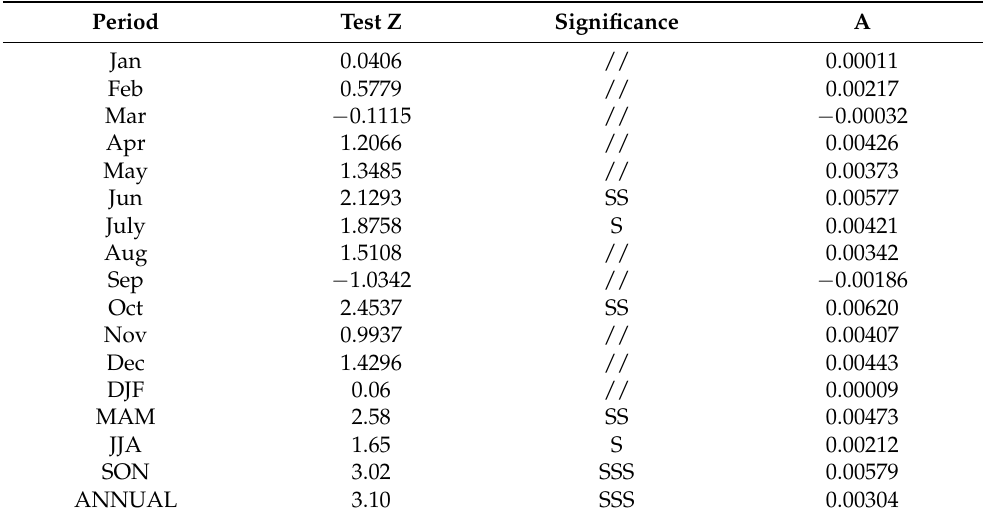
Table 6. Tm monthly, seasonal, and annual analyses. The MK trend is reported in the second and third columns. Non-significant values are identified with “//”. A 90% significance level is highlighted with “S”, 95% with “SS”, and 98% with “SSS”. The right-side column reports the Sen’s slope estimator A. Period Test Z Significance A Jan 0.0406 // 0.00011 Feb 0.5779 // 0.00217 Mar − 0.1115 // − 0.00032 Apr 1.2066 // 0.00426 May 1.3485 // 0.00373